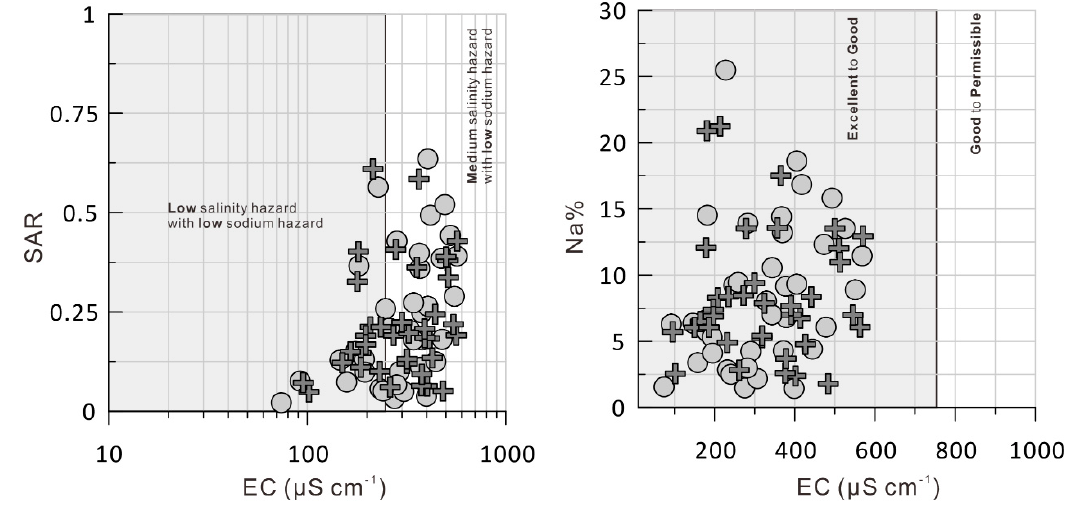
Figure 7. The standards of the USSL diagram (sodium absorption ratio (SAR) vs. electrical conductivity (EC)) and Wilcox diagram (%Na vs. EC) for assessing the water quality for irrigation use. The grey dots are the water samples collected during the low-flow season (LFS) and the black crosses are those collected during the high-flow season